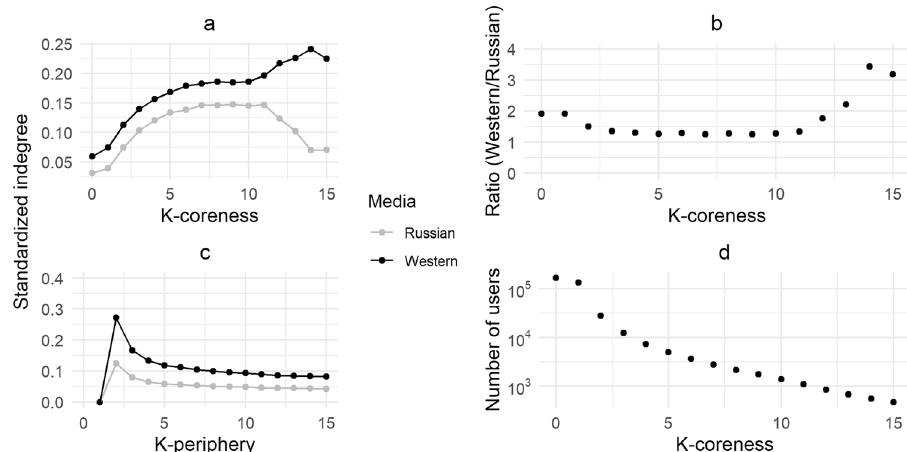
Fig. 3 The impact of Russian state-controlled news media in the core/periphery of the retweet netwrok. a Standardized in-degree for the outlets combined in the core/periphery. b Ratio between standardized in-degree for Western and Russian outlets. c Standardized in-degree in the periphery (outside of the respective core). For example, k = 1 periphery consists of nodes that are excluded from the k = 1 core. d Number of users in the respective K-core, where k = 0 is the entire network.